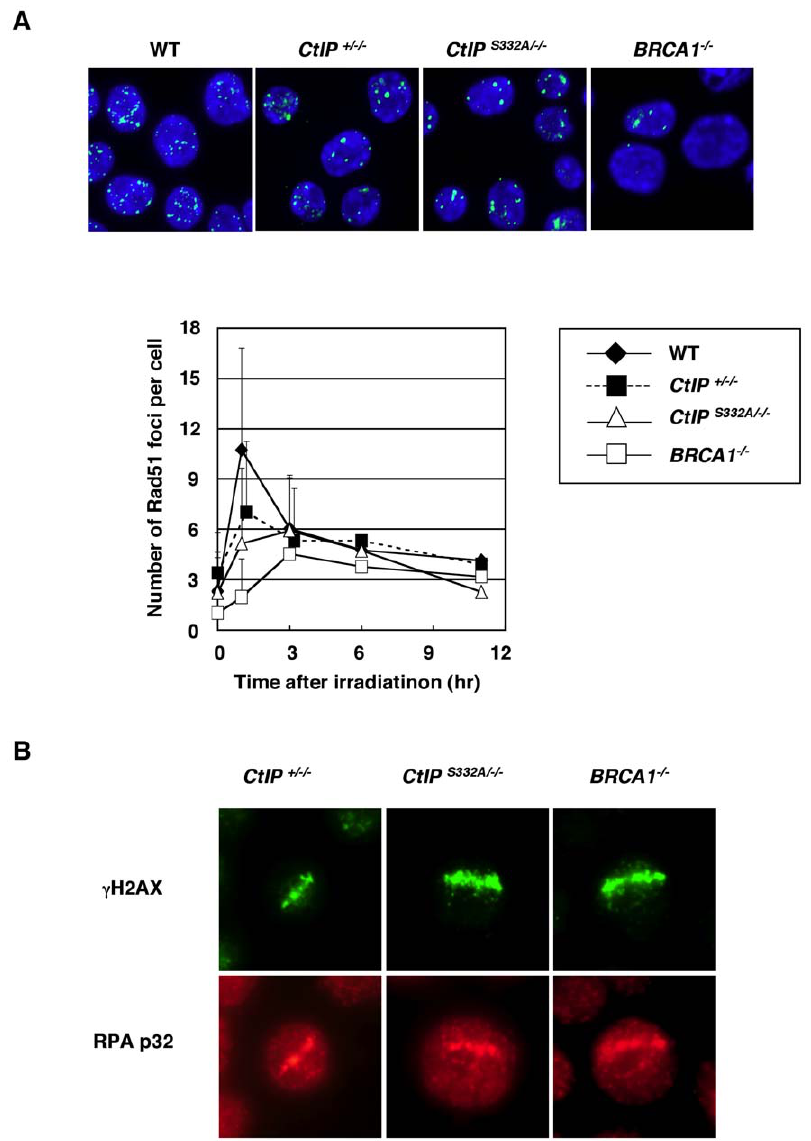
Figure 4. Accumulation of Rad51 and RPA at DNA damage sites is indistinguishable between CtIP + / 2 / 2 and CtIP S332A/ 2 / 2 clones. (A) Rad51 focus formation in CtIP mutant cells. The cells of indicated genotype were irradiated with 8Gy of c -ray, and were immuno-stained with anti- Rad51 antibodies 1 h after irradiation. The lower graph shows the quantification of Rad51 foci per cell. More than 100 cells were analyzed. Error bars indicate S.D. (B) The subnuclear accumulation of RPA in the cells exposed to 405 nm pulse laser. The cells were fixed with 4% PFA 1 h after exposure, and were stained with anti- c H2AX and anti-RPA p32 antibodies.